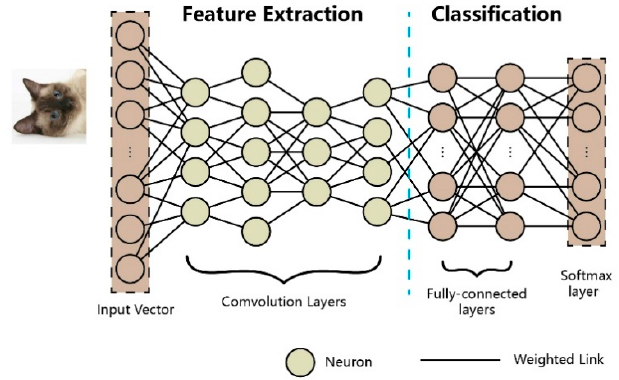
Figure 2. The architecture of a deep neural network.